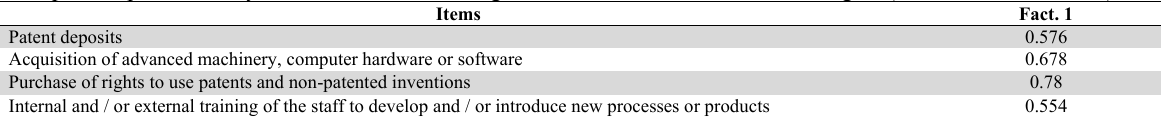
Principal components analysis of the variable relating to innovation activities: Factor Weights (Varimax Standardized)